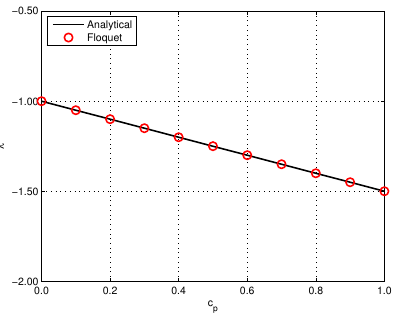
Figure 1. Comparison of the characteristic exponents obtained by analytical solution and numerical method